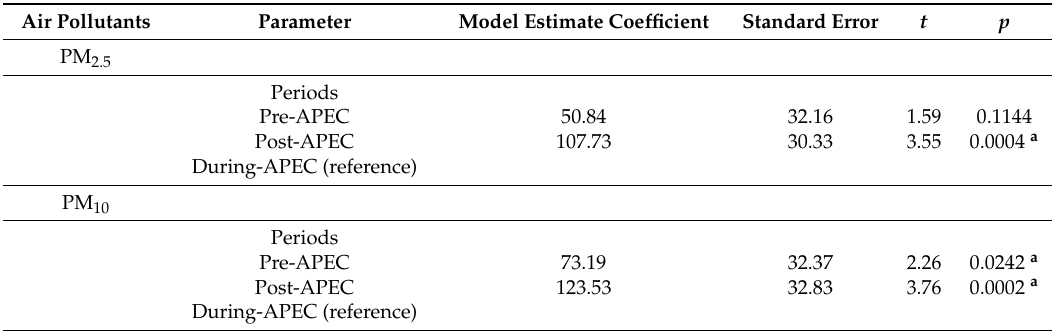
Table 2. The influence of the emission control measures on particulate matter controlling for confounding factors.